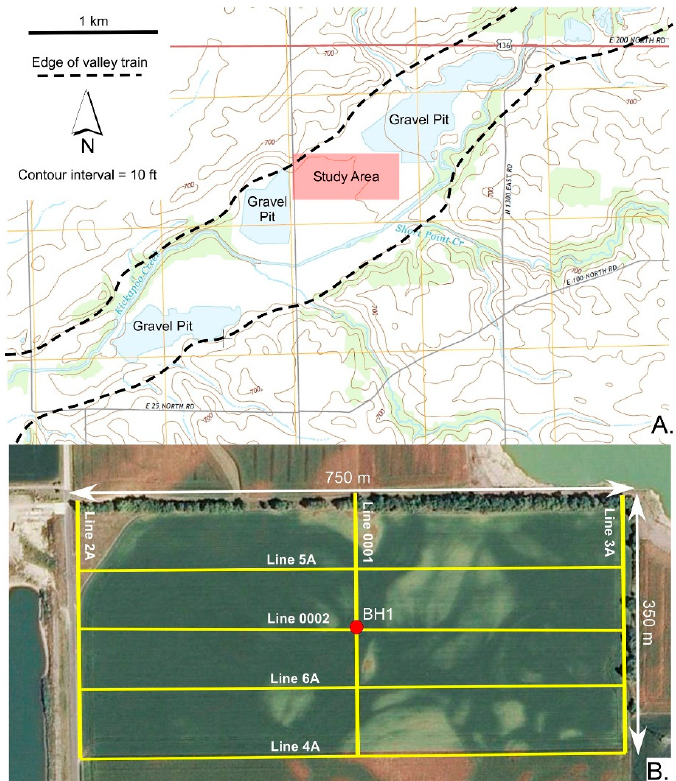
Figure 3. ( A ) Topography map of the Kickapoo Creek valley west of Heyworth, IL that indicates the study area and the outline of the valley train outwash deposit; ( B ) Air photo of the study area indicating the seismic profile shot lines. The yellow lines are the locations of the seismic profiles. The borehole is indicated by BH01.